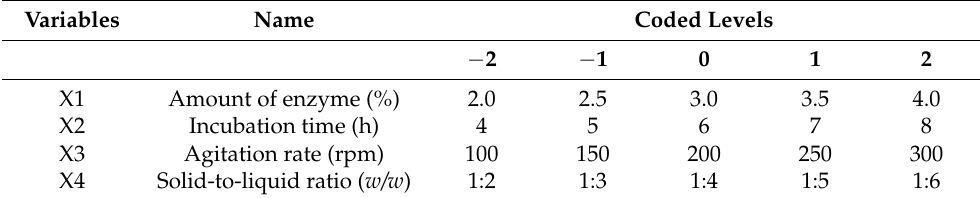
Table 5. AEE process variables and their levels used in